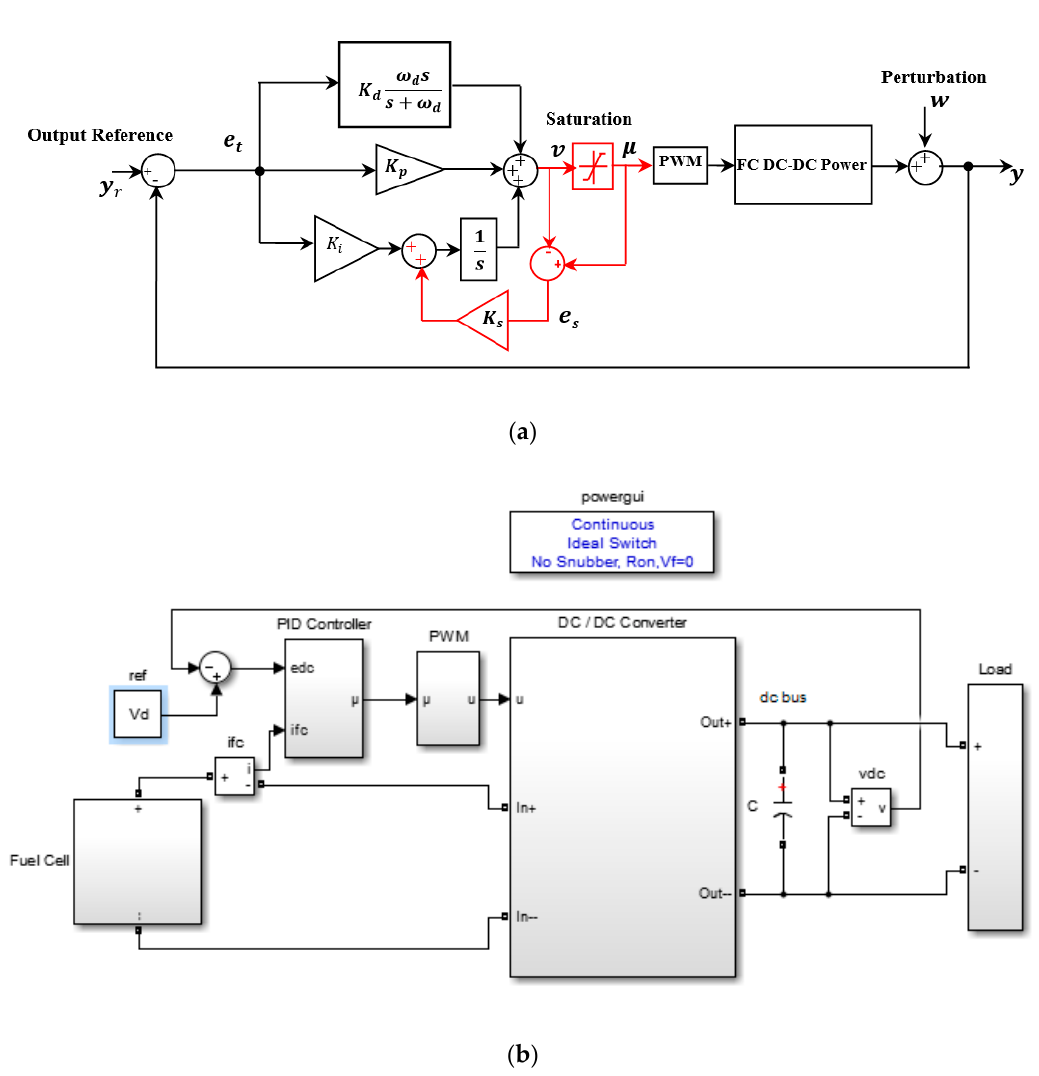
Figure 6. ( a ) PID controller of power converter with anti-windup. ( b ) Block diagram of the controlled system.